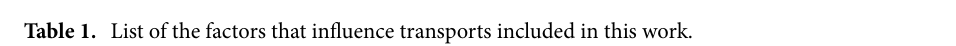
random motility alone is limited (Fig. S2b black dotted). But this migration is greatly facilitated by bacterial pH-taxis from acidic duodenum fluid into pancreatic duct containing pancreatic juice at slightly alkaline pH (Figs. 2 green, S2a, b blue and green). Note aerotaxis of aerobic bacteria away higher carbon dioxide concentra- tion at the duodenum affects migration little since the pH-tactic velocity is approximately tenfold larger than aerotactic velocity (Fig. S2b blue and red).